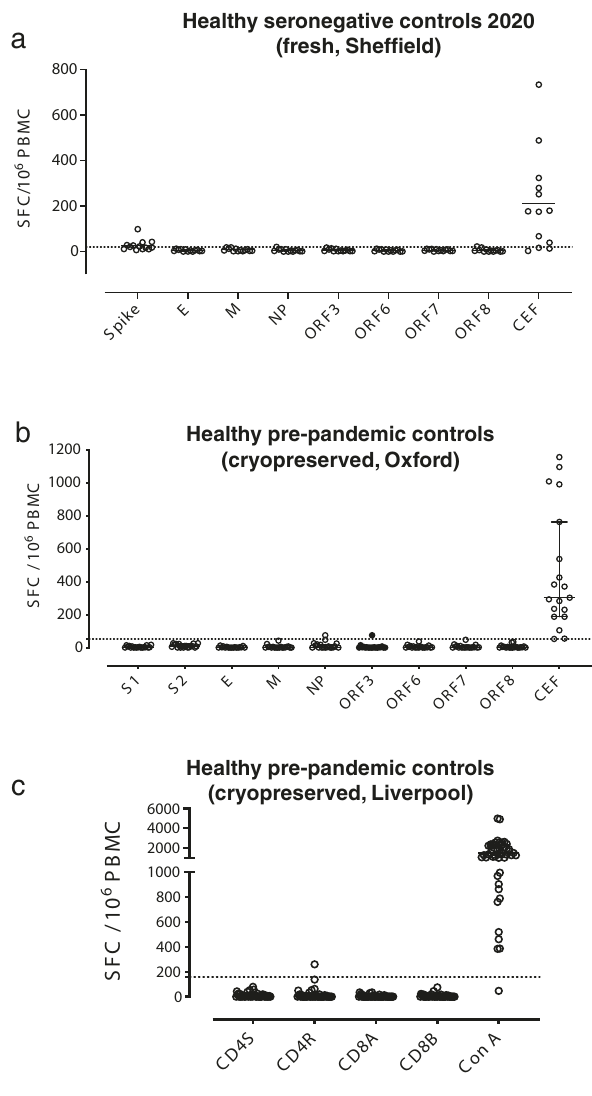
Fig. 5 Ex vivo ELISpot responses in seronegative controls. Ex vivo IFN- γ ELISpot responses to summed SARS-CoV-2 peptide pools spanning spike, accessory and structural proteins (E, M, NP, ORF 3, ORF6, ORF7 and ORF8) and CEF T cell control panel in a freshly isolated peripheral blood mononuclear cells (PBMC) from seronegative controls in Shef fi eld, UK ( n = 13), and b cryopreserved PBMC from pre-pandemic healthy controls in Oxford, UK ( n = 19). c Ex vivo IFN- γ ELISpot responses to in silico-predicted epitope pools 10 cryopreserved PBMC from pre-pandemic healthy controls in Liverpool, UK ( n = 48). Responses are shown with background subtracted, a line represents mean + 2 stand deviations of responses to the